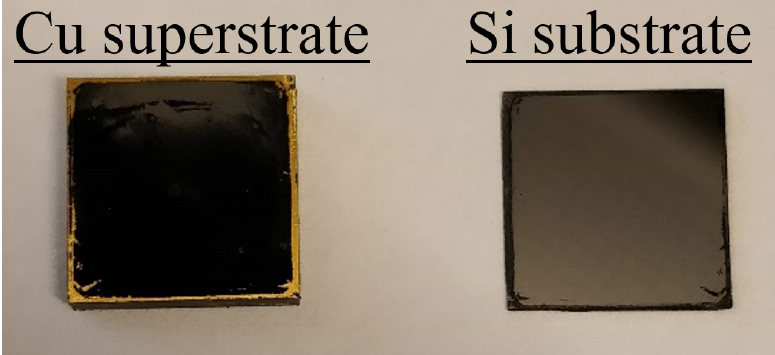
Figure 6. Shearing of the CNT array TIMs always resulted in a delamination where the CNTs remained on the Cu superstrate side leaving the Si substrate with a clean